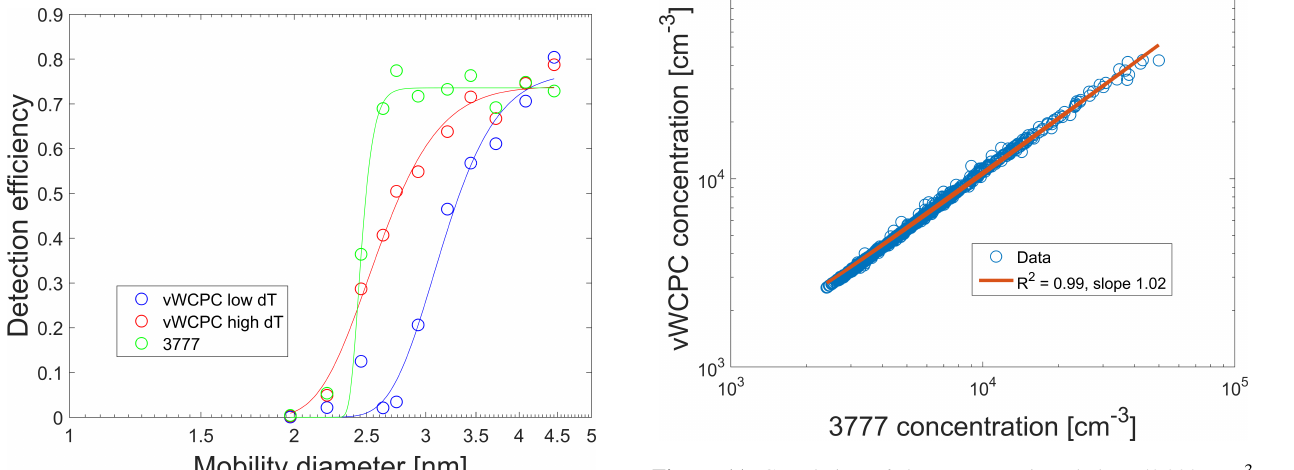
Figure 11. Correlation of the concentrations below 50000cm − 3 measured by the CPCs for the same data as in Fig.